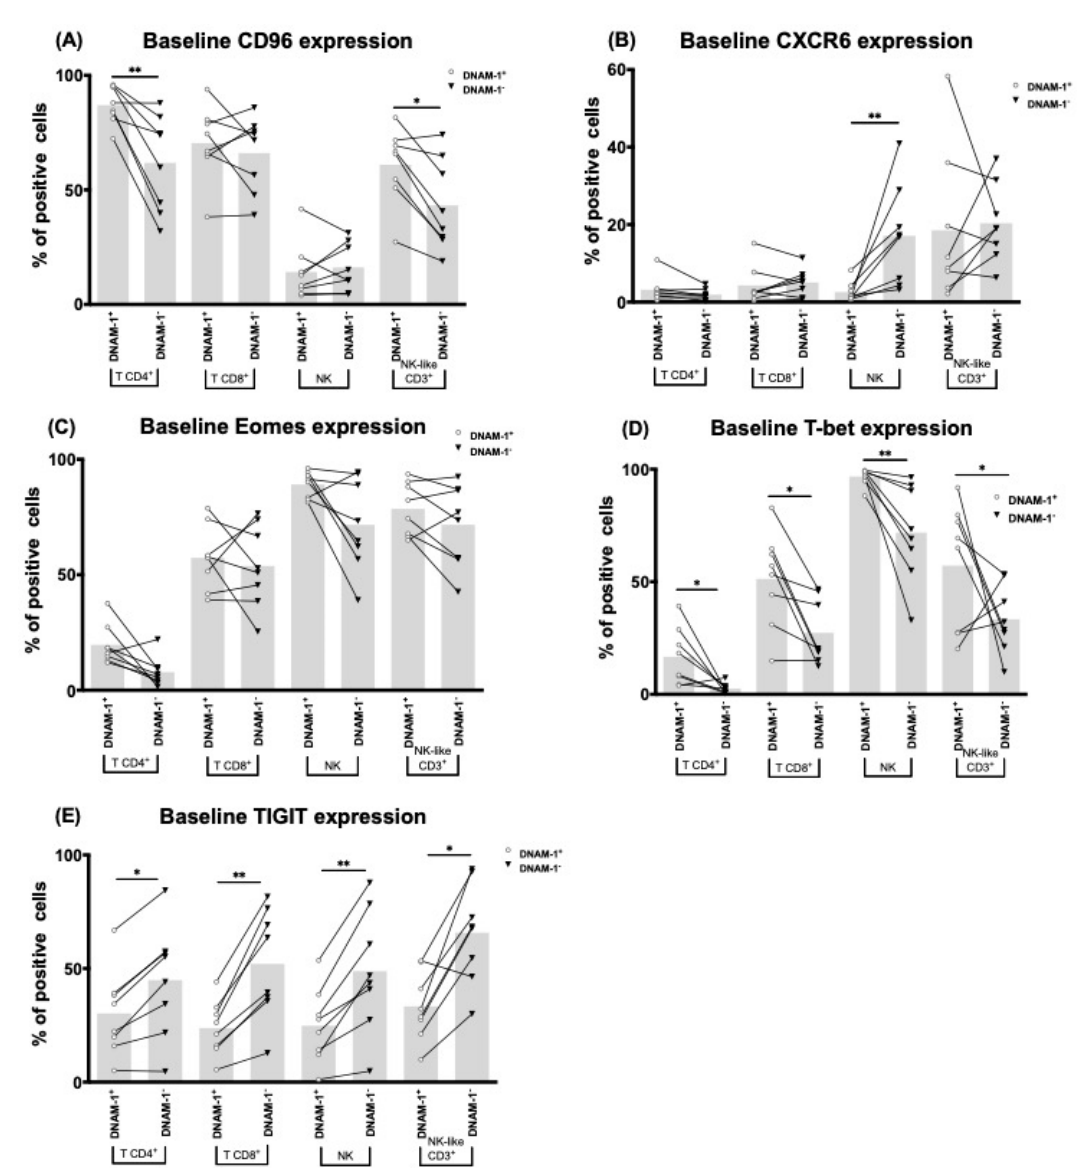
Figure 5. DNAM-1 + cells characterization. CD96 ( A ), CXCR6 ( B ), Eomes ( C ), T-bet ( D ), and T Cell Immunoreceptor with Ig and ITIM Domains (TIGIT) ( E ) positive cells across the DNAM-1 + and DNAM-1 − subgroups of T and NK cells of sorafenib treated patients at baseline ( n = 8). Bar height represents the mean of each group. *: p < 0.05, **: p <